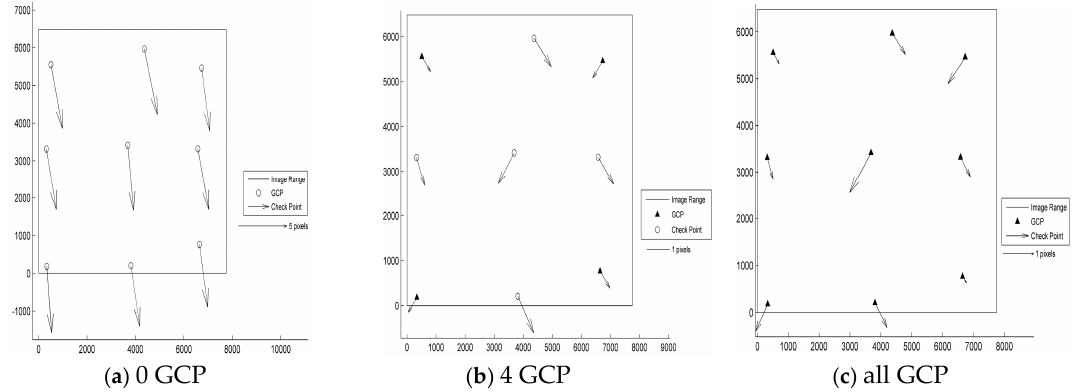
Figure 6. Residual distributions of check points of the QPSI mode orientation for Tianjin: ( a ) 0 GCP; ( b ) 4 GCP; ( c ) all GCP.